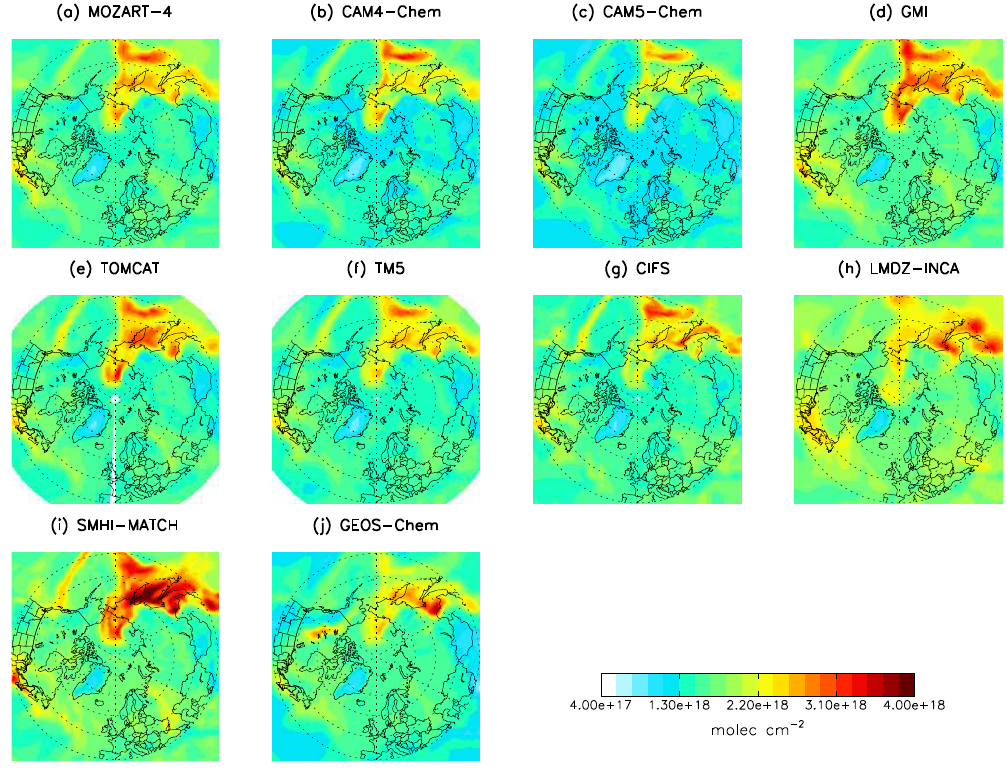
Figure 9. Total column CO from the POLMIP model simulations at 06:00UT on 7 July 2008.